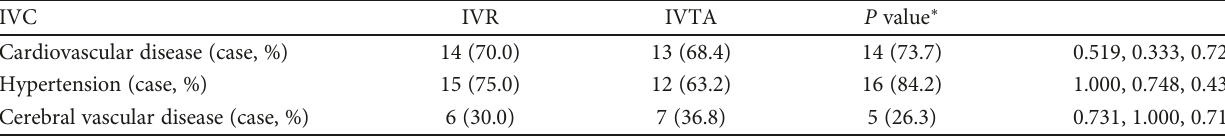
Figure 4: Secondary outcomes and adverse events of the IVC, IVR, and IVTA groups at 6m. There were no signi fi cant di ff erences in vitreous clear-up time and the incidence of intraoperative bleeding between IVC and IVR groups, while both of these groups were signi fi cantly di ff erent from IVTA group. More patients were at high IOP level in the IVTA group than the other two groups after surgeries. However, there were no statistically signi fi cant di ff erences in the incidence of postoperative bleeding, PRP completion rate, and reoperation probability among 3 groups. Table 5: System adverse events compared with